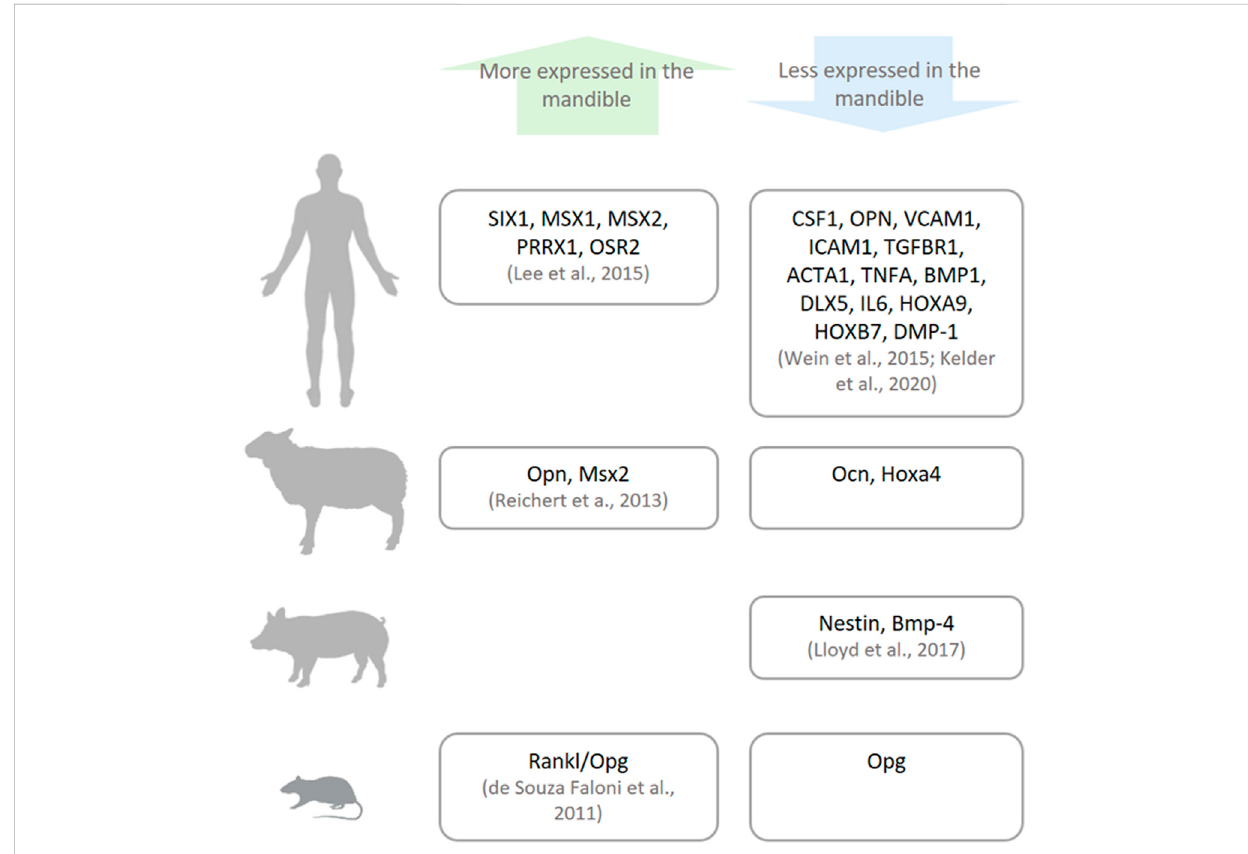
FIGURE 4 Genetic differences between the mandible and other bones. There are differences in the expressions of speci fi c genes (named in the boxes) in humans, sheep, pigs, and small animals (rats and mice) as reported in the